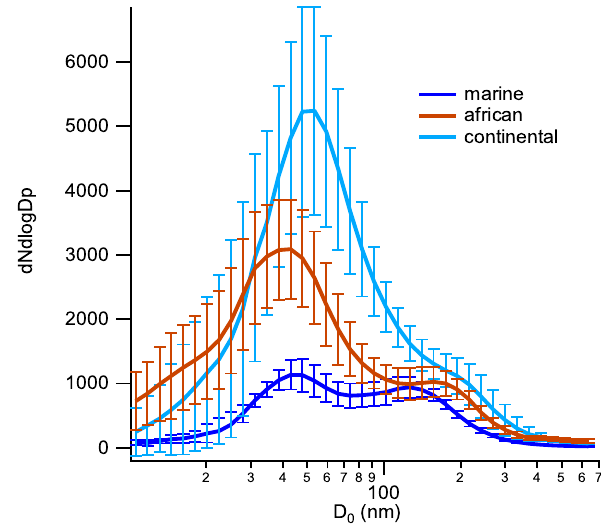
Fig. 1. Discovery D319 cruise track. The coloured sections of the track indicate the 3 study periods. The grey sections transitions between study periods. 5 day back-trajectories are shown along the track to illustrate the air mass origins.